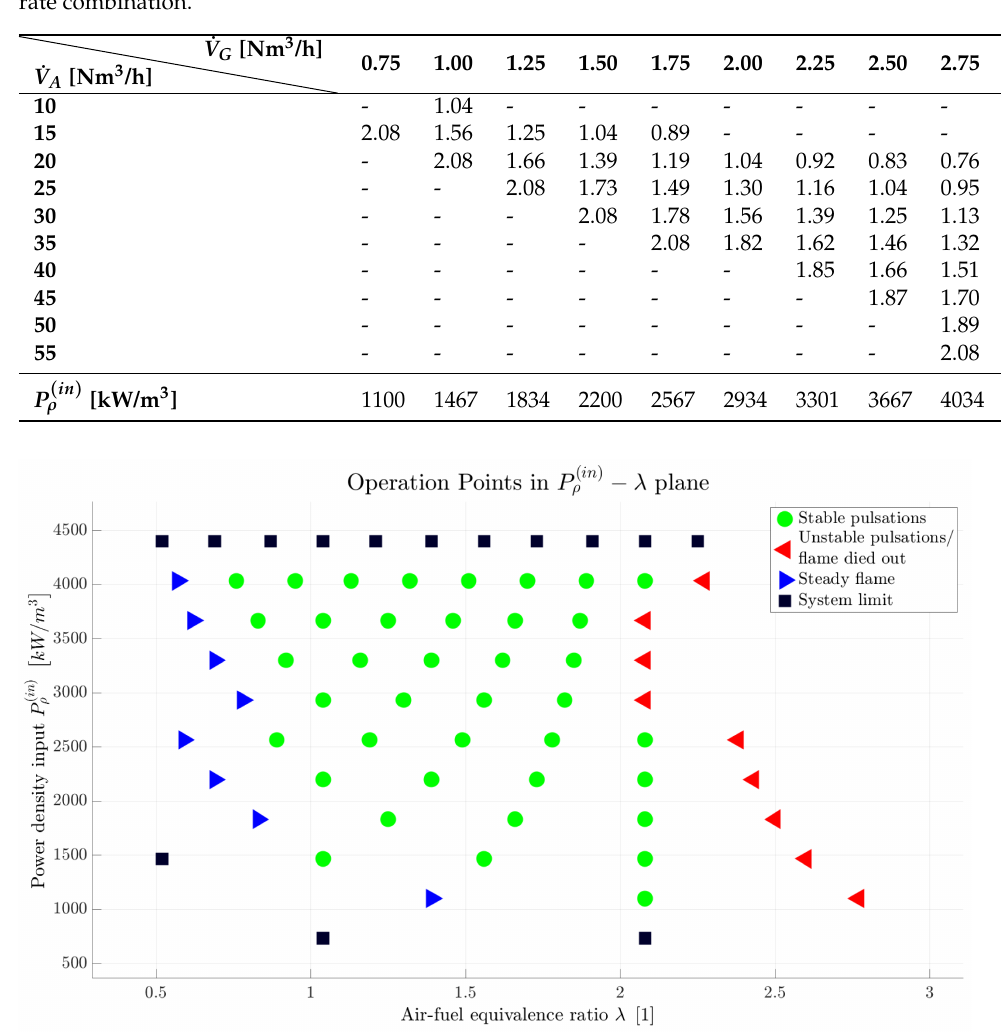
( in ) − λ plane. Since the airflow rate was ρ